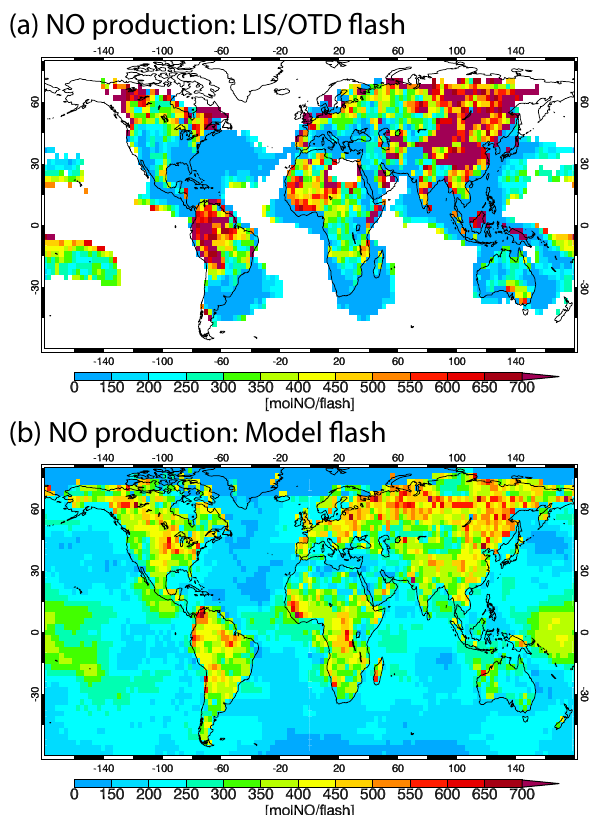
Fig. 14. Global distributions of the NO production efficiency (molNOflash − 1 ) estimated from the annual total LNO x sources analyzed from data assimilation for 2007 with (a) the LIS/OTD HRMC flash climatology data (Cecil et al., 2014), and with (b) the model flash rate for 2007. The results in (a) are shown for the re- gion with the observed annual flash rates of greater than 0.44 flashes km − 2 yr − 1 to avoid unrealistically large